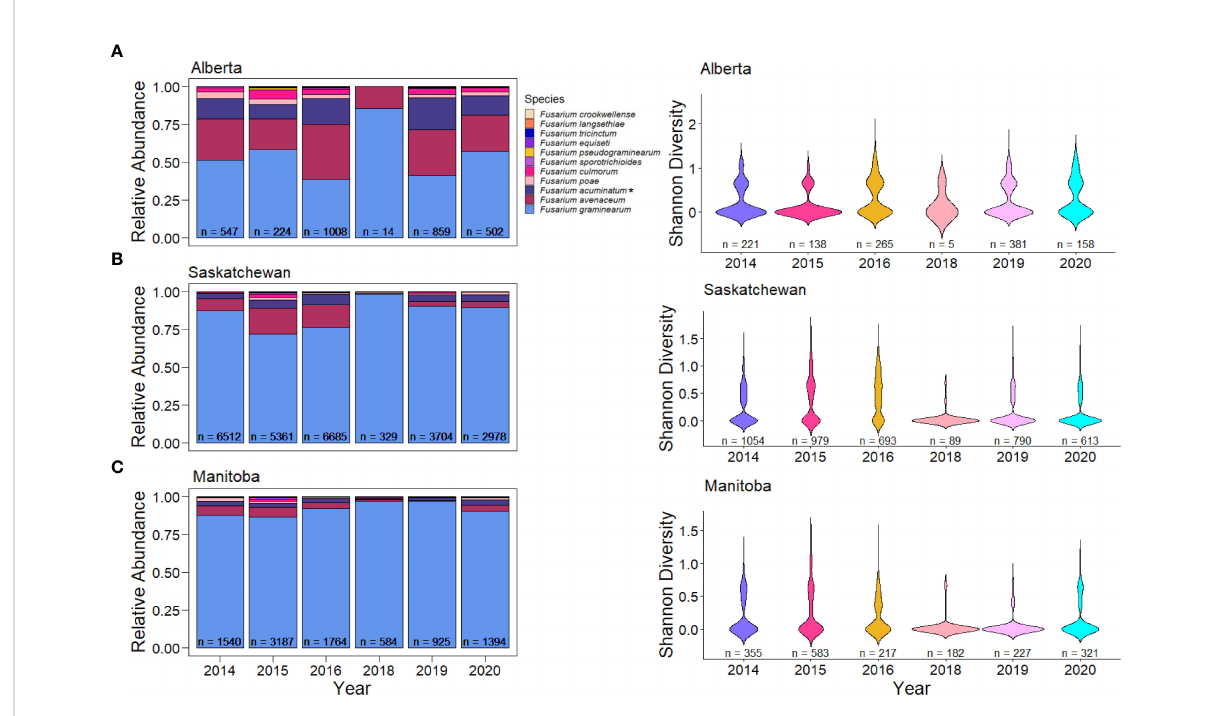
FIGURE 3 Relative abundance in kernels and species diversity in wheat samples of Fusarium species in western Canadian provinces across all years. (A) Relative abundance and species diversity of Fusarium species in Alberta. (B) Relative abundance and species diversity of Fusarium species in Saskatchewan. (C) Relative abundance and species diversity of Fusarium species in Manitoba. Asterisks (*) signify putative F. acuminatum